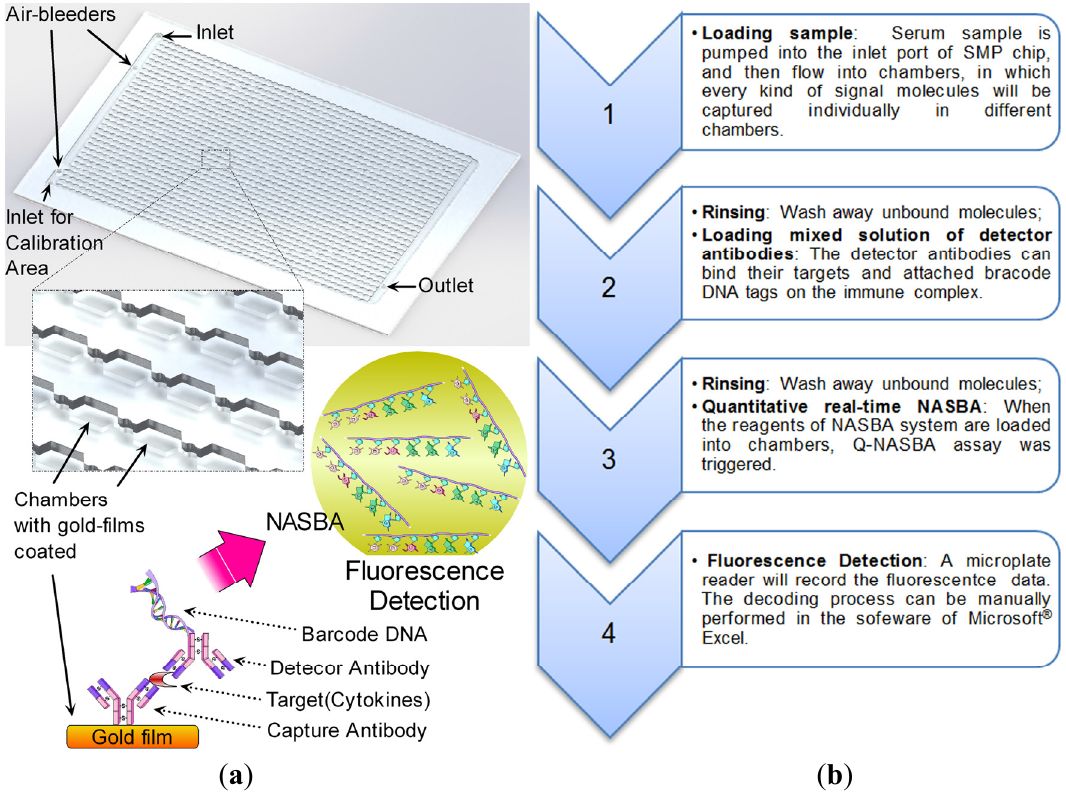
Figure 4. Structure of a SMP chip and its operation flow. ( a ) Gold films coated the surfaces of the poly (methyl methacrylate). Different capture antibodies for respective targets were immobilized on the gold film in every chamber. The principle of immuno-NASBA assay is similar to sandwich enzyme-linked immunosorbent assay (ELISA), however, the report group in the detector antibody is a barcode DNA with a T7 RNA polymerase promoter instead of an enzyme. The barcode DNA plays as a bridge to connect immunoassay and NASBA amplification. Then fluorescent signals will be generated in the NASBA amplification with the help of beacon probes. ( b ) The operation flow is proposed on the